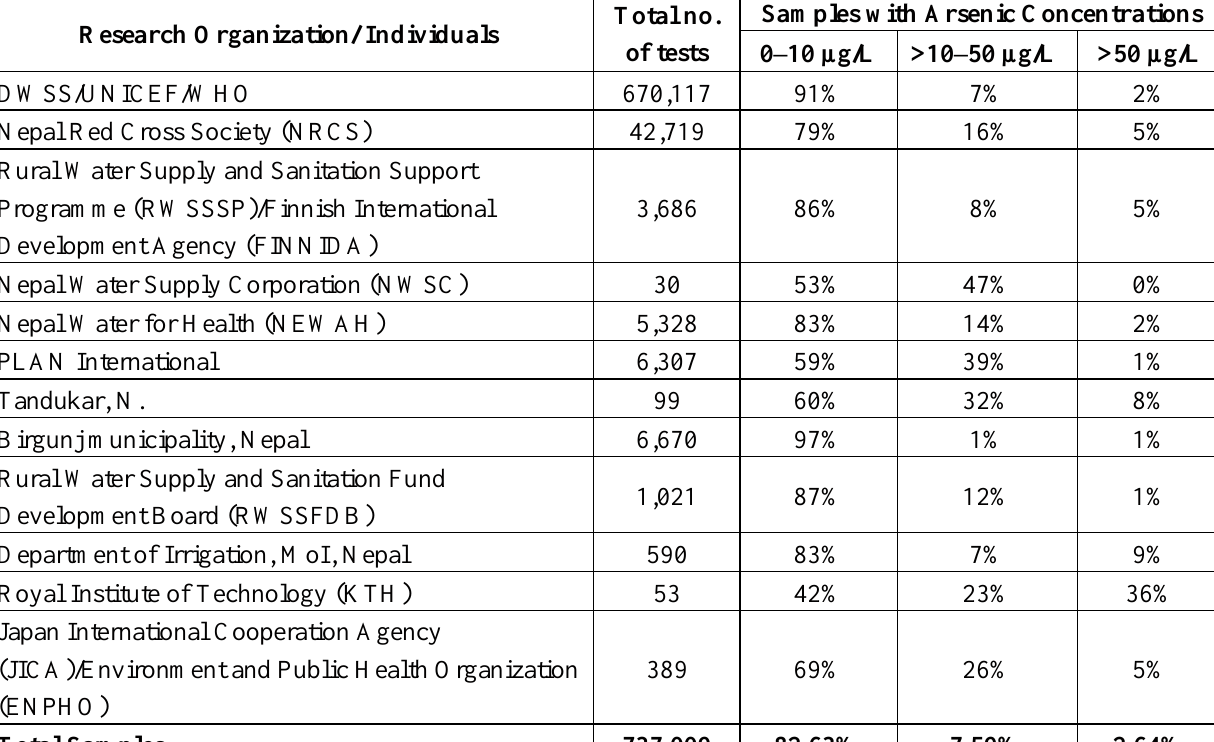
Table 2. Statistical summary of relative total groundwater arsenic contamination samples subdivided per institution or group